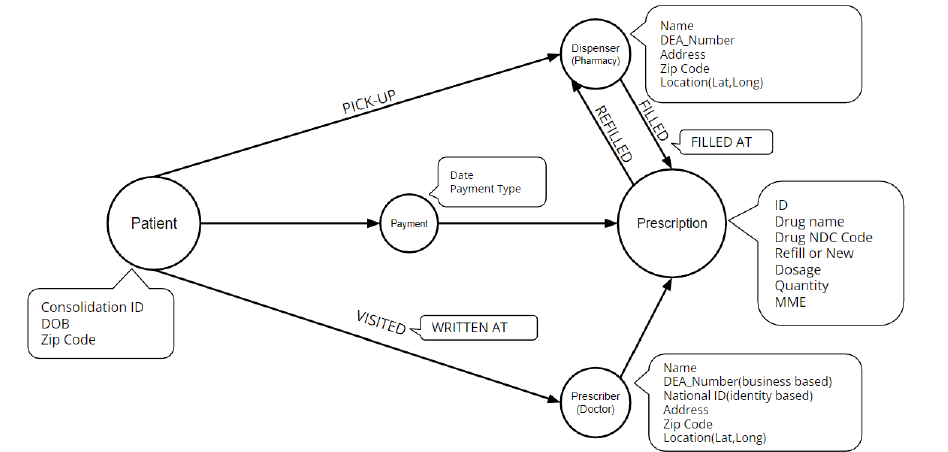
Figure 1. Metagraph of the SCRIPTS